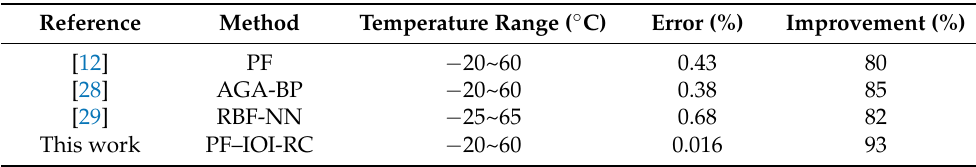
Table 3. Comparation between this work and other